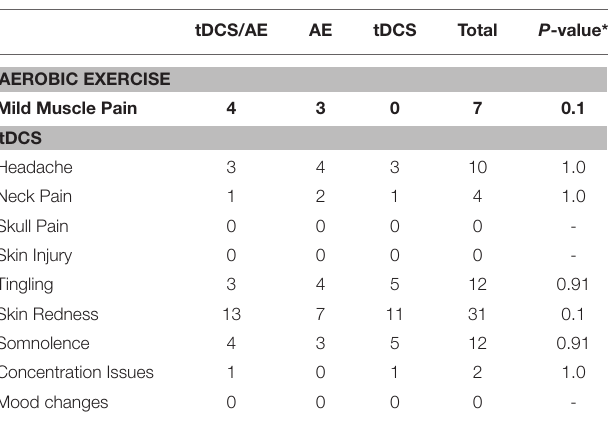
TABLE 5 | Pain intensity data stratified by level of depression.